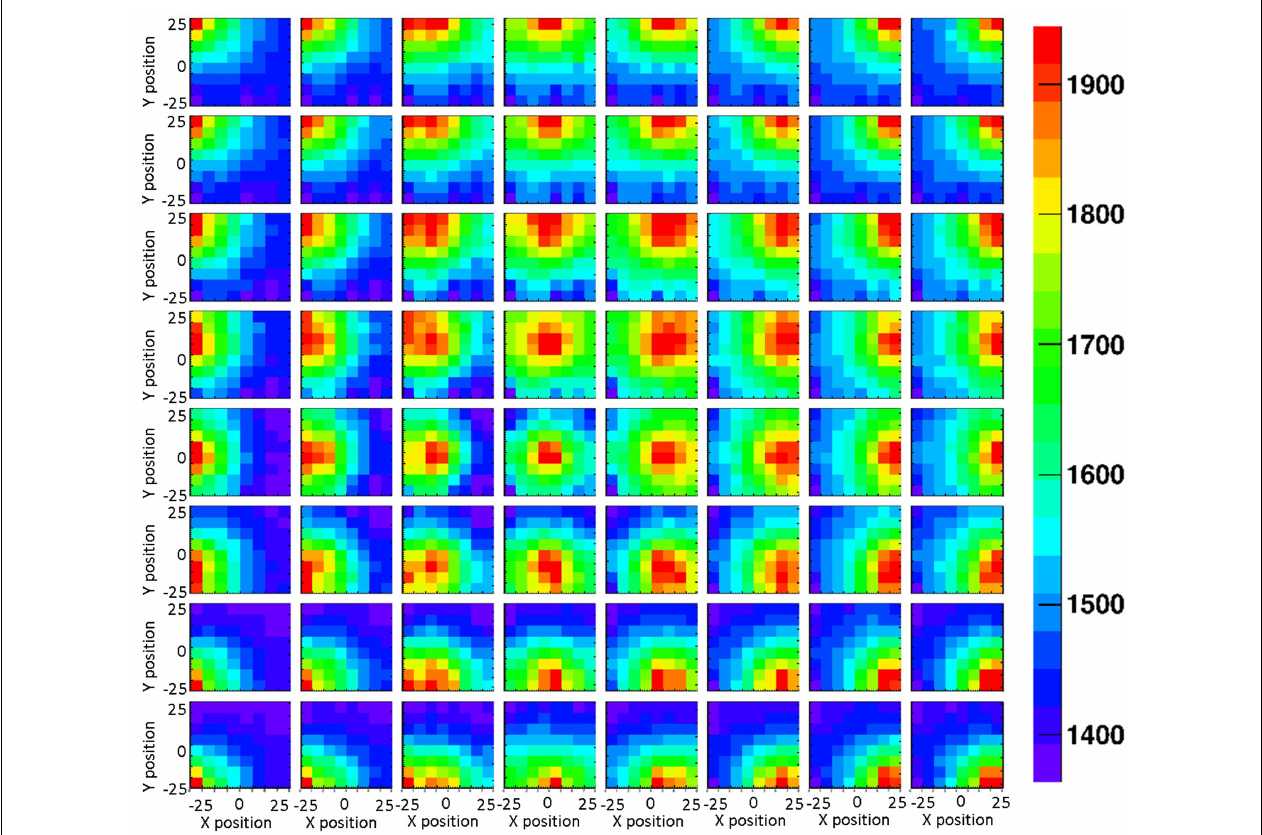
FIGURE 7 | A grid scan of 8 (cid:2) 8 irradiation positions of the reflectively coated LaBr 3 :Ce detector, using a 1-mm collimated 137 Cs source . The source irradiation position can be clearly tracked by the intensity of the detector 2D light distribution.